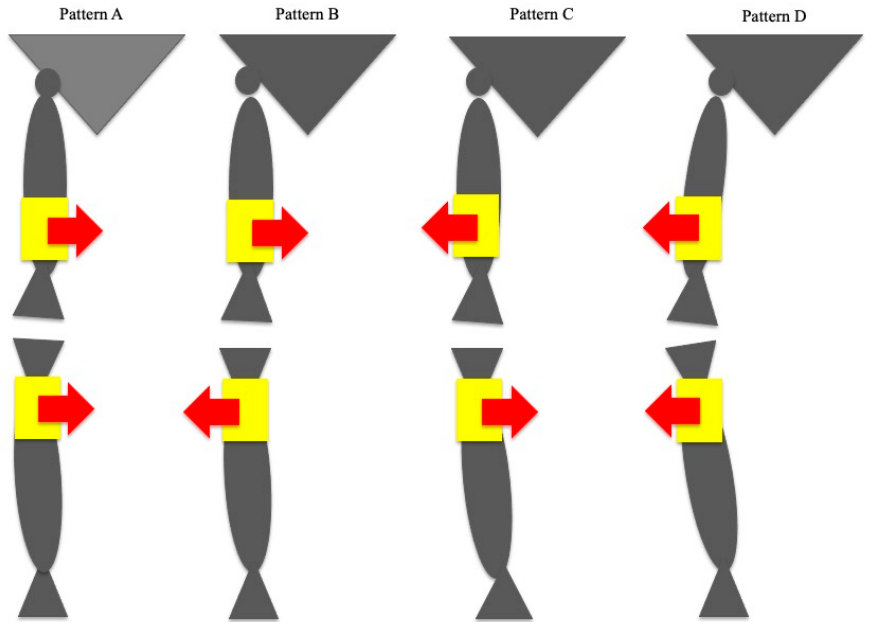
Figure 3. IMU classification according to the angular acceleration pattern. Red arrows: the directions of medial-lateral acceleration.